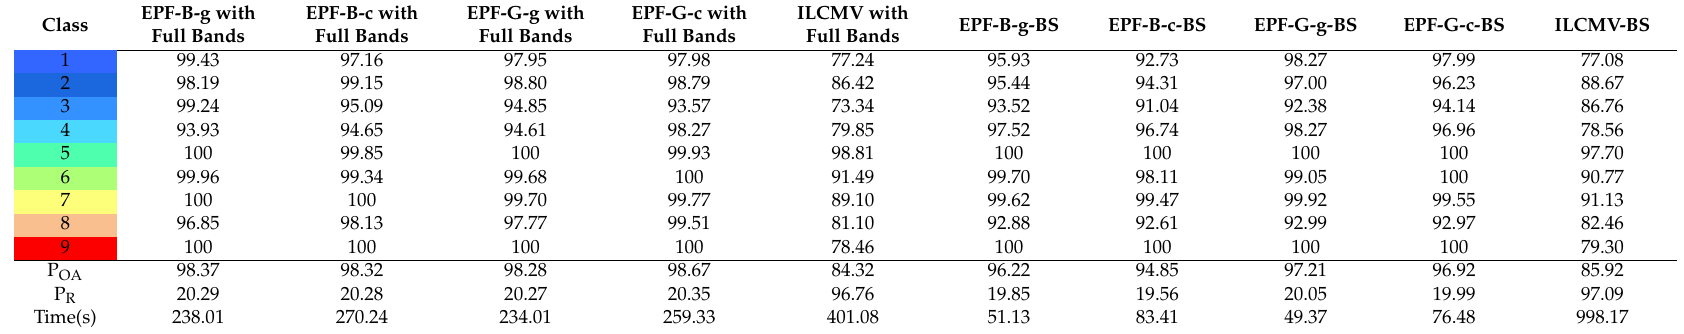
Table 15. P OA and P R calculated by the classification results using full bands and the bands selected by SC LCMV-BSS in Table 2 for University of Pavia. EPF-B-g with EPF-B-c with Class Full Bands Full